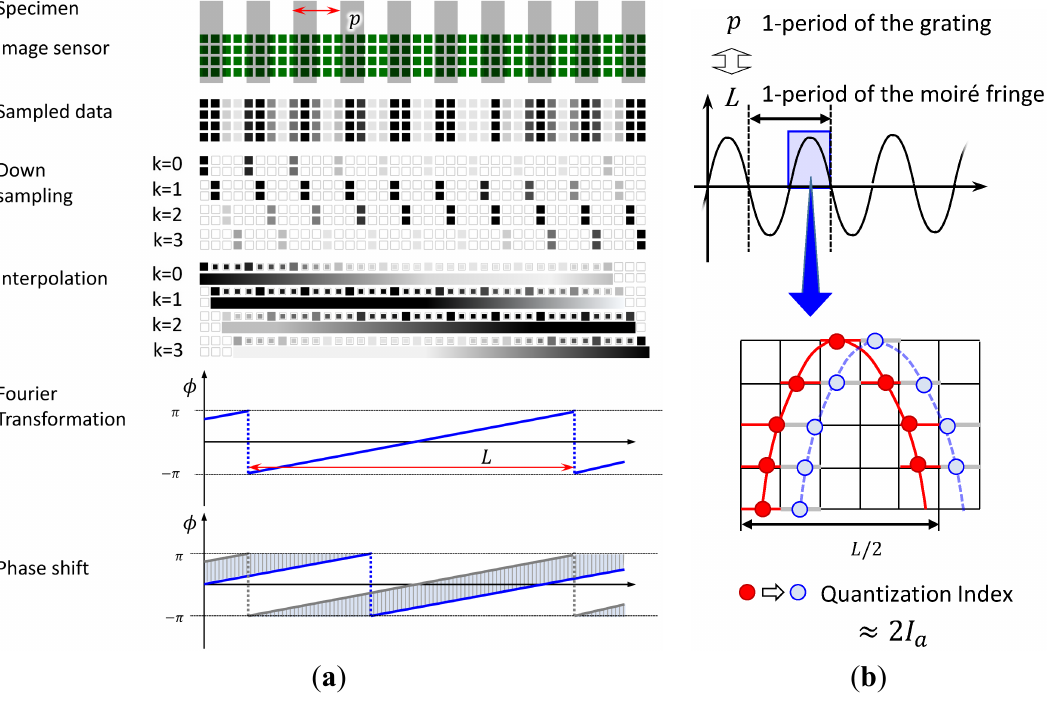
Figure 4. ( a ) Schematic image of the phase detection with moiré fringe and ( b ) the measurement factors related to the improvement of